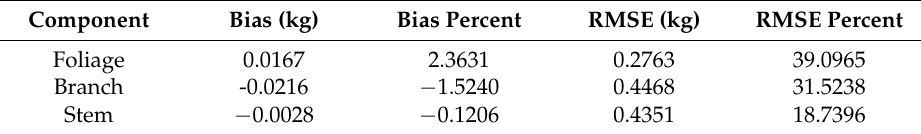
Table 6. Bias and root mean squared error obtained from Dirichlet regression.